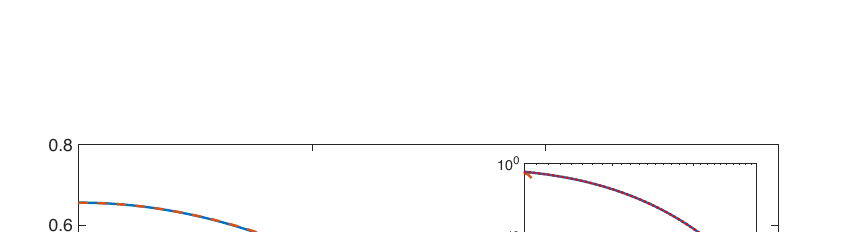
( x ) = − x 2 and C = 8.10 − 4 0